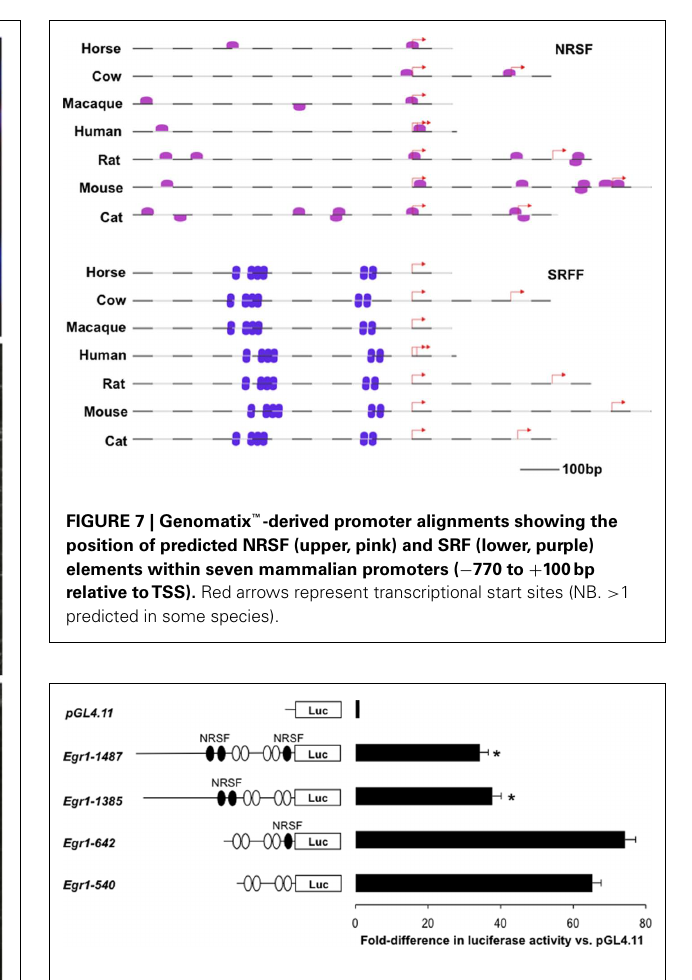
FIGURE 8 | Functional analysis of Egr-1 promoter activity in transfected cells: role of NRSF sites. DNA constructs derived from rat Egr-1-d2EGFP transgene were cloned into pGL4.11 and transfected into 3T3 cells. Levels of expression were determined by luciferase (Luc) assays and corrected against a co-transfected renilla luciferase construct. Histogram shows expression levels of the different constructs relative to empty pGL4.11 (Mean ± SE, n = 8; * p < 0.05 vs. Egr-1-642 and Egr-1-540 groups, ANOVA andTukey’s multiple comparison test; df = 3, F = 57.28).The position of the predicted NRSF and SRF elements (see text) are indicated by filled and unfilled ovals